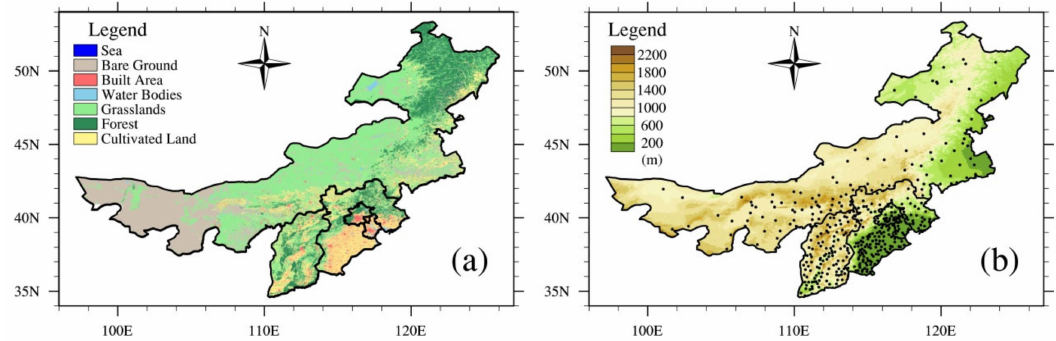
Figure 1. Land use distribution ( a ) and meteorological station distribution ( b ) in North China in